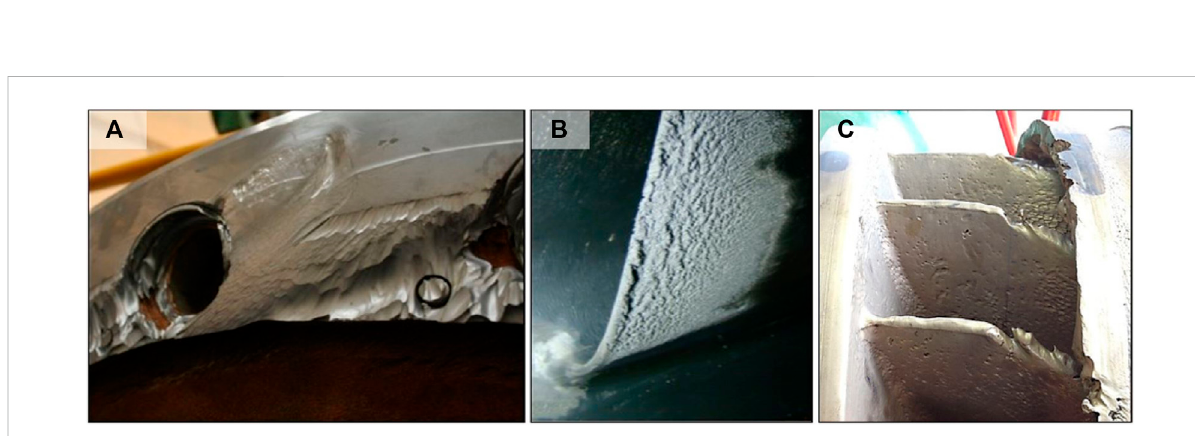
FIGURE 2 Erosion damageinthecomponents ofthreeFrancisturbines: (A) hard-particle erosioninoneofthecovers, (B) cavitation damageatthetrailing edgeofoneoftherunnerblades,and (C) synergisticdamageofthehardparticlesandcavitationattheleadingedgeoftherunnerblades(Teranetal.,